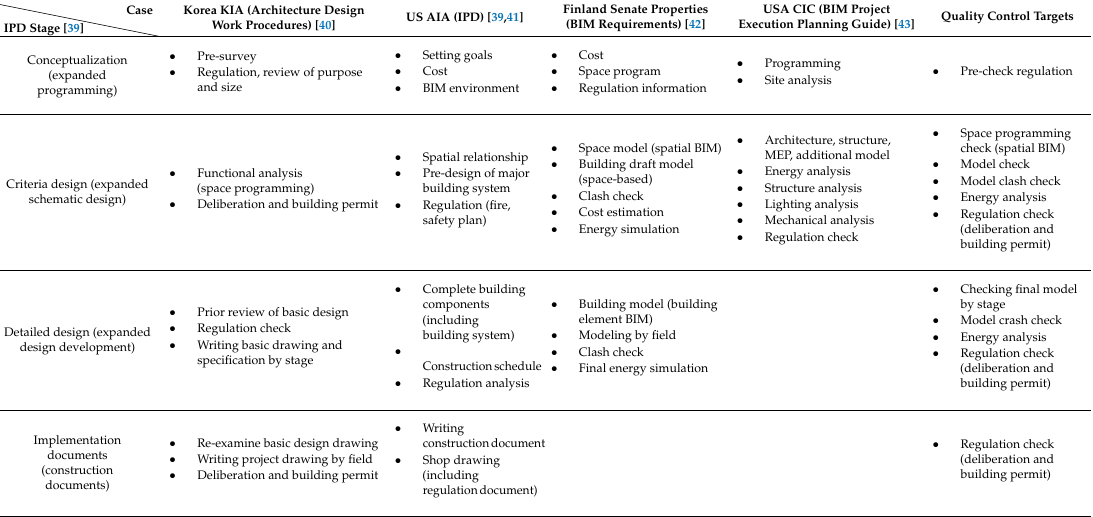
Table 4. Quality control targets by stage through analysis of the architectural design